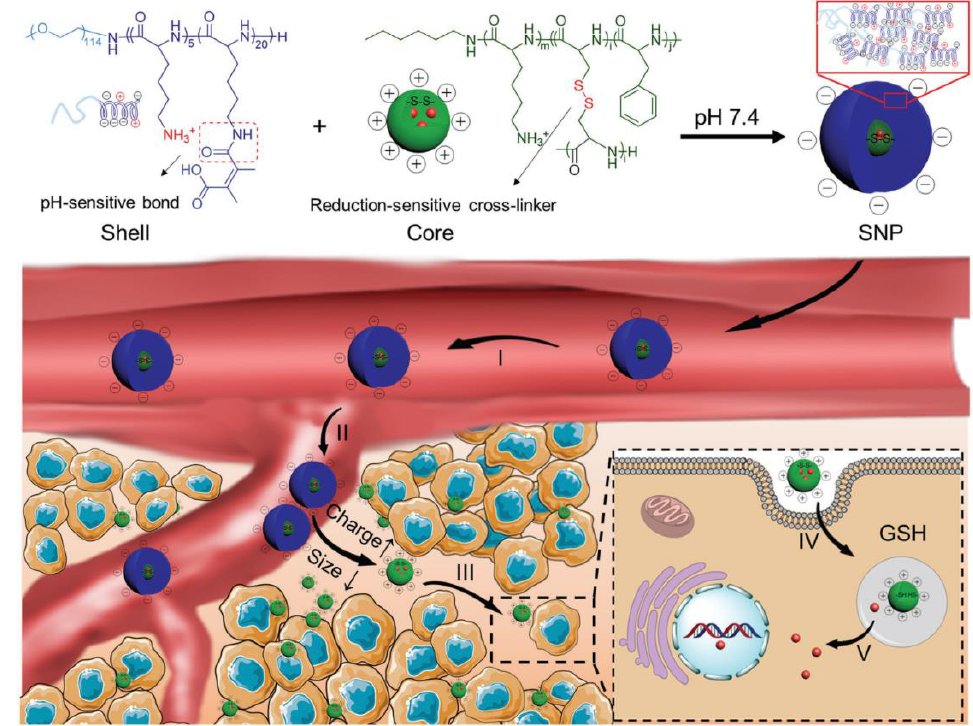
Figure 11. Formation and deep tumor penetration of shell-stacked nanoparticle (SNP). SNP is composed of a PEGylated and negatively charged shell, and a positively charged and disulfide-cross- linked polypeptide core, through electrostatic interaction. Owing to the tumor-microenvironment- mediated multi-transformations, SNP could lead to a perfect cascade of drug delivery. (I) Long cir- culation. (II) Enhanced accumulation. (III) Deep penetration. (IV) Promoted internalization. (V) Ac- celerated drug release. Reprinted with permission from Ref. [71]. © 2017 WILEY‐VCH Verlag GmbH & Co. KGaA, Weinheim. Table 2. Examples of different transition polypeptide systems for anti-tumor drug delivery.